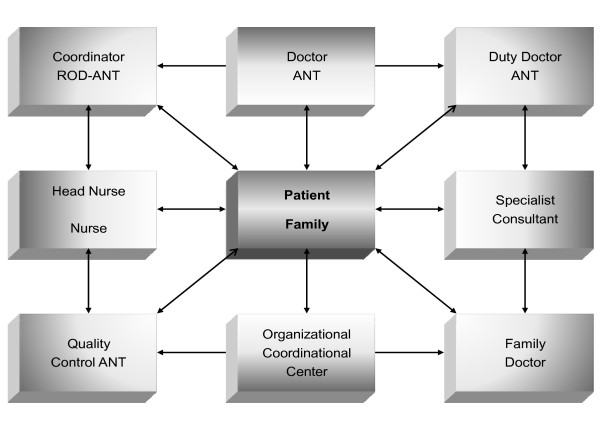
The structure of the OHH unit (see text for details).